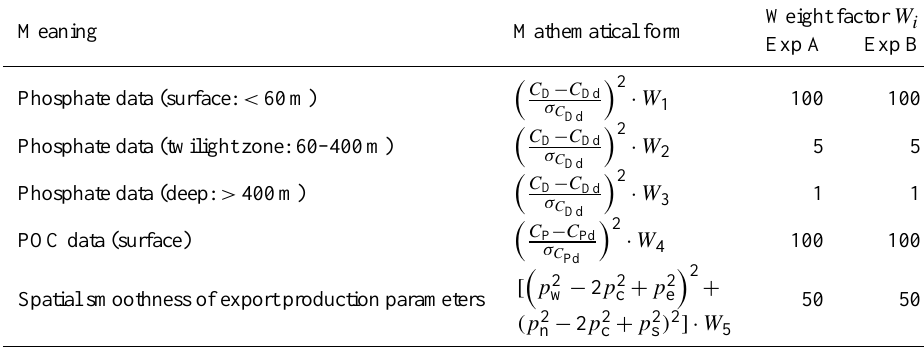
Table 2. Description of individual terms in the cost function F . Meaning